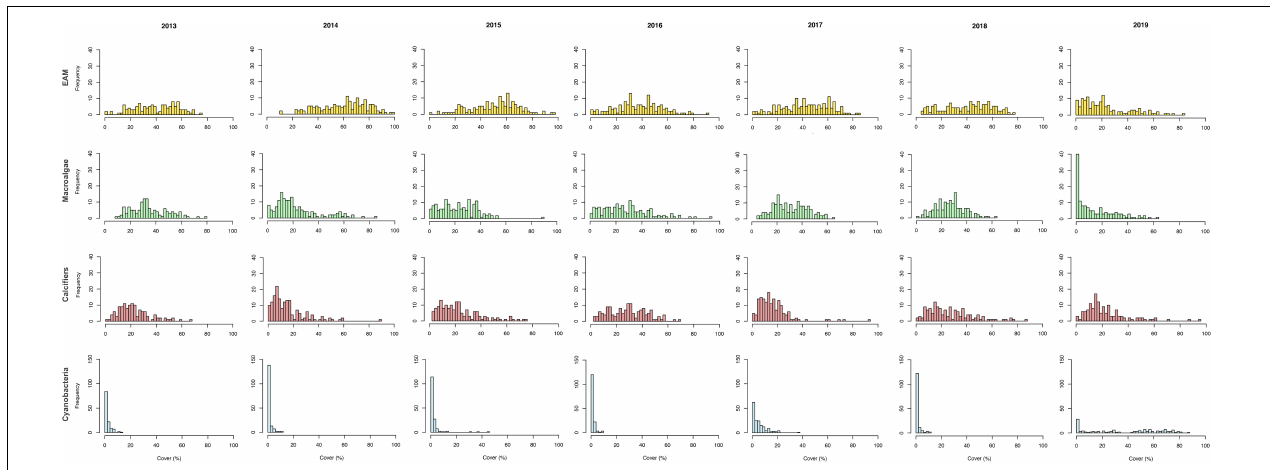
FIGURE 5 | Frequency variation on benthic groups coverage. Frequency histograms of epilithic algal matrix (EAM; yellow), macroalgae (green), calcifiers (red) and cyanobacteria (blue) percentage cover during the 7-year monitoring in Fernando de Noronha Archipelago.